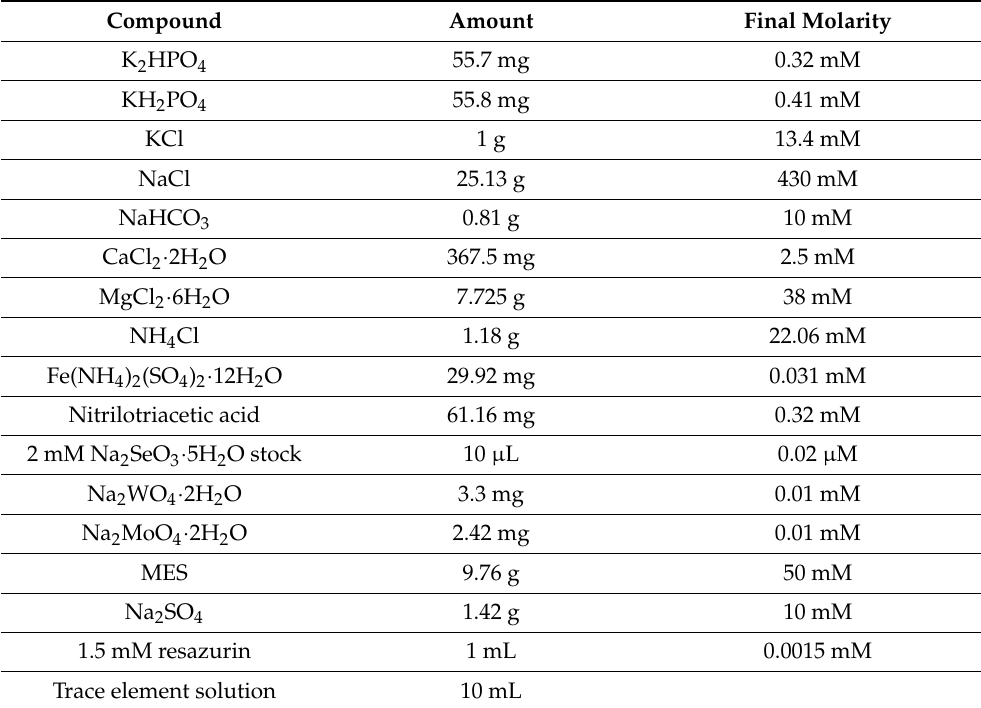
Table 1. Medium components for M. thermolithotrophicus